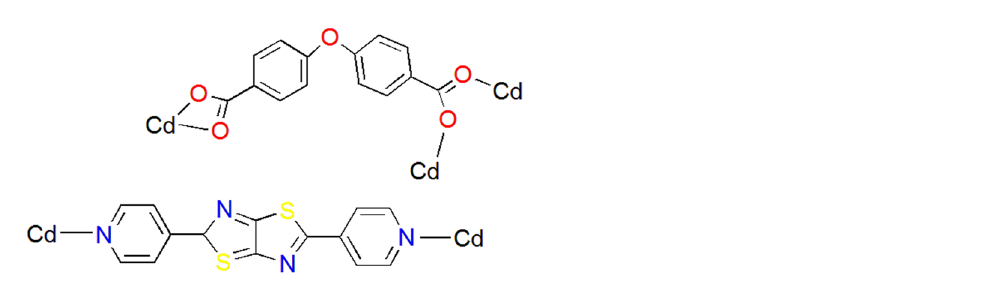
Figure 2. Coordination modes of the DPTTZ and OBA ligands in the